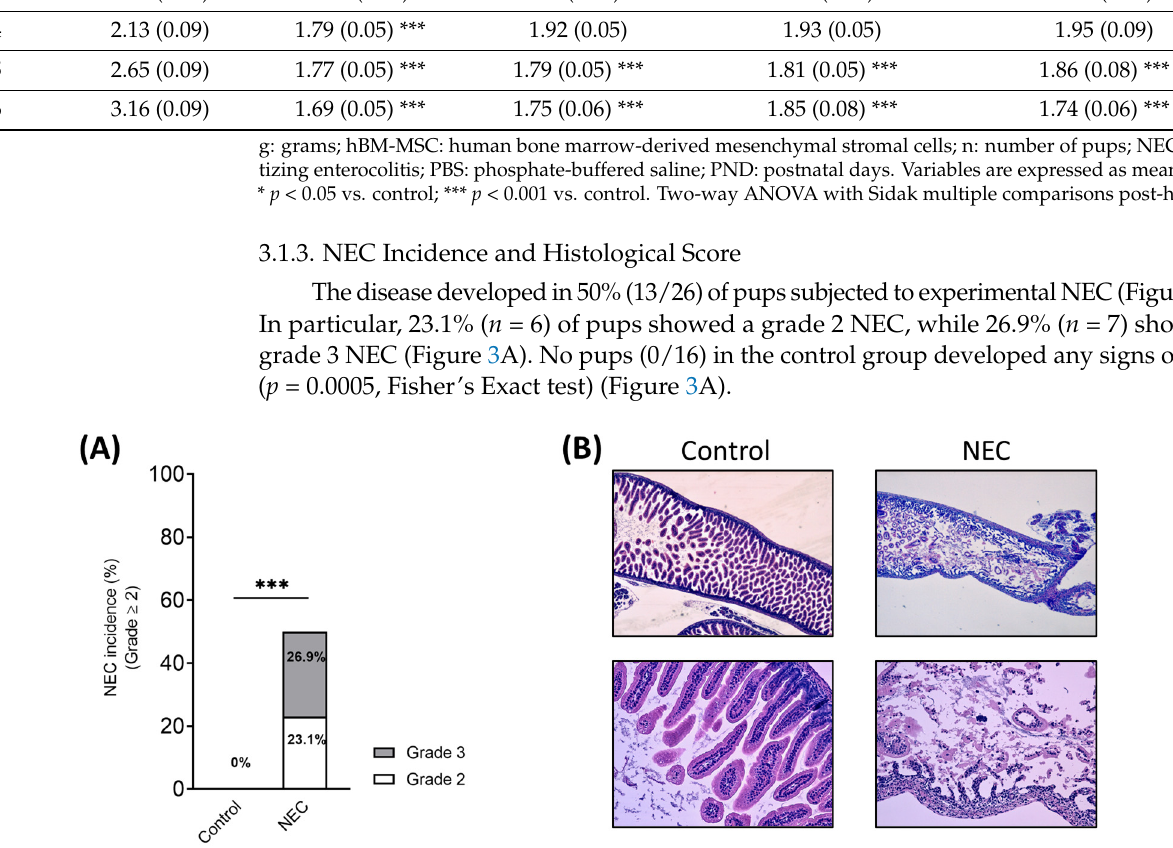
Figure 3. Term infant formula feedings, hypoxic–ischemic insults, and enteral LPS administration induced NEC in a neonatal mouse model. ( A ) NEC histological grading and incidence in control ( n = 16) and NEC ( n = 26) groups. ( B ) Representative histological sections from each group (hematoxylin/eosin staining). Image magnification: upper panels, 40×; lower panels, 100×. LPS: lipopolysaccharide; NEC: necrotizing enterocolitis. *** p ≤ 0.001 (Fisher’s exact test).